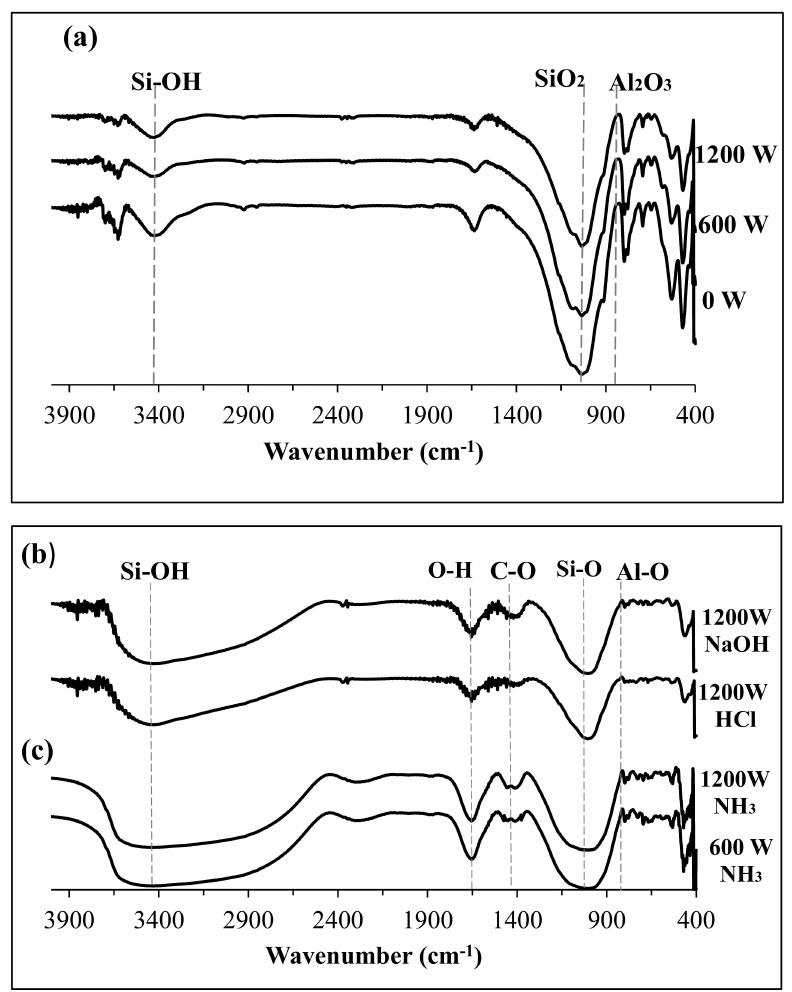
Figure 10. FT-IR analysis after geopolymerization of 1200 W US ( a ) treated soil with no additive. ( b ) treated with 0.1 M NaOH (top) and 0.1 M HCl (bottom) ) and ( c ) treated with 0.1 M